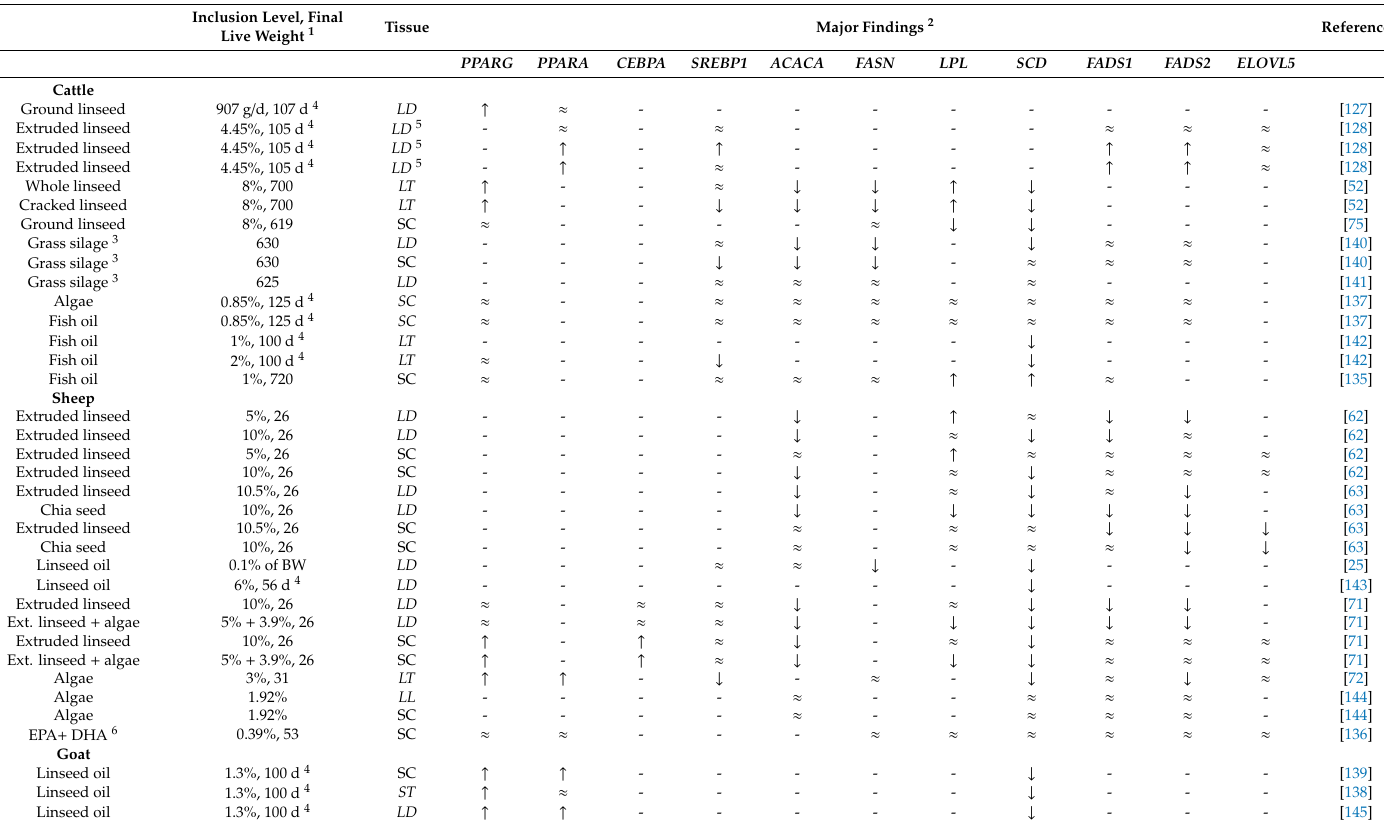
Table 3. Results of di ff erent studies of the e ff ect of dietary inclusion of n -3 long chain polyunsaturated fatty acid (PUFA) rich sources on the adipogenic and lipid metabolism gene expression in